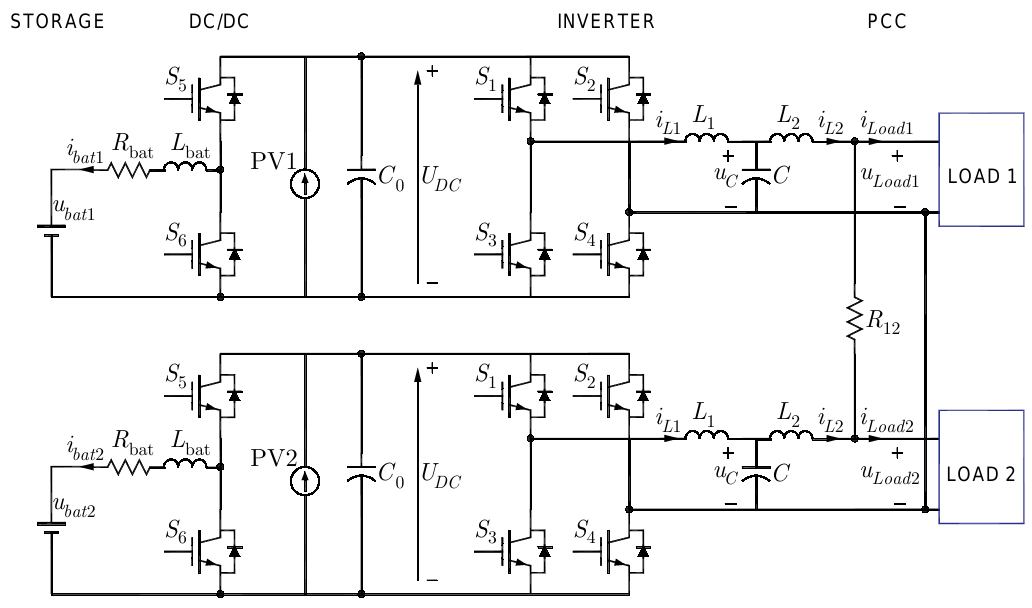
Figure 5. Nanogrid simulation model. Table 2. Simulation parameters.